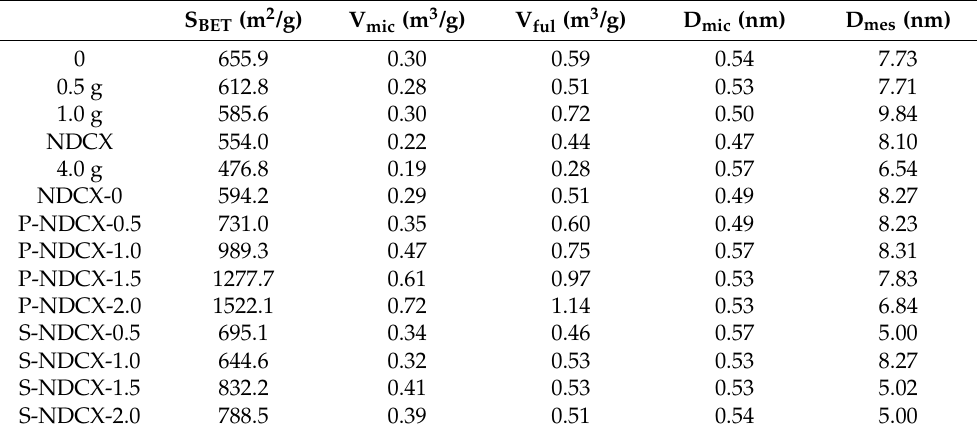
Table 1. Textural properties of NDCX, S-NDCX-1.0, and P-NDCX-m obtained from the N 2 physisorp- tion